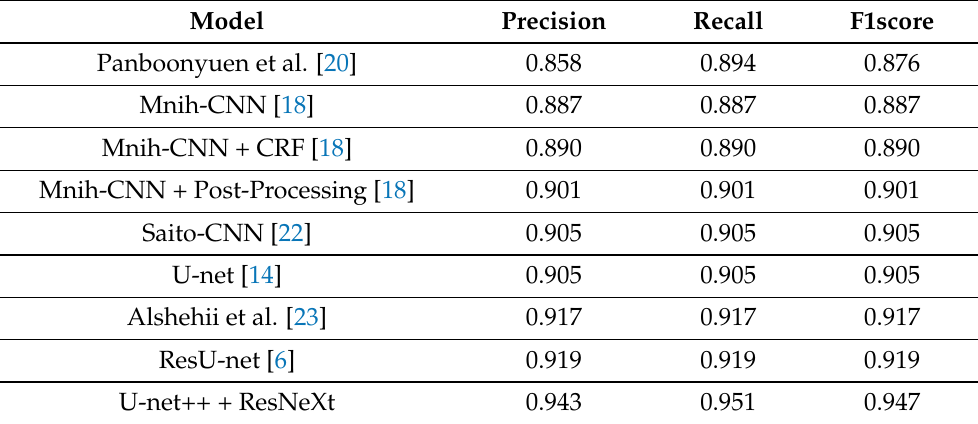
Table 2. Comparison of the model with previous approaches on Massachusetts Test Roads dataset: metrics that were not available for all the papers were excluded.